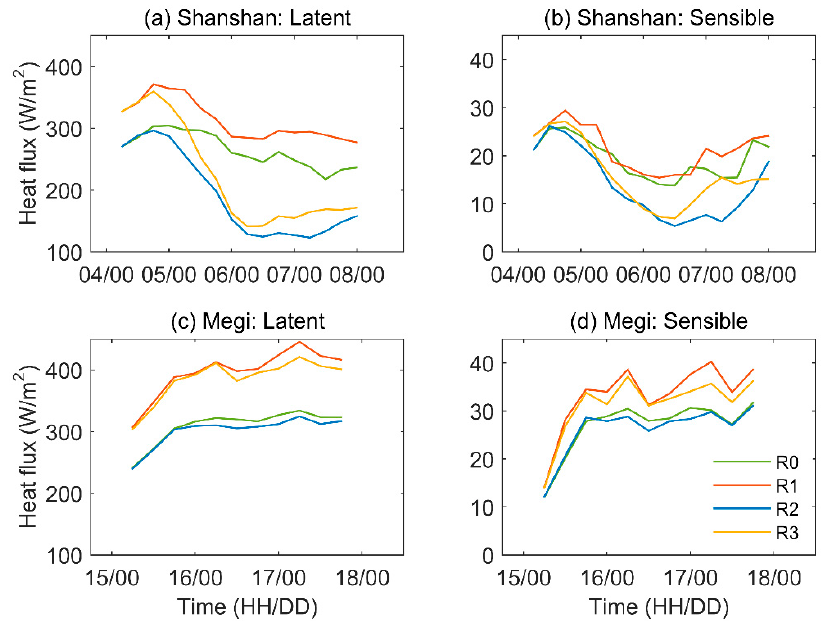
Figure 14. Evolution of heat fluxes. ( a ) Latent heat fluxes averaged over the 300 km radius inner core region along Shanshan center location; ( b ) same as ( a ), but for sensible heat fluxes; ( c ) same as ( a ), but for Megi; ( d ) same as ( b ), but for Megi. See Section 3.1 for details of the simulations.